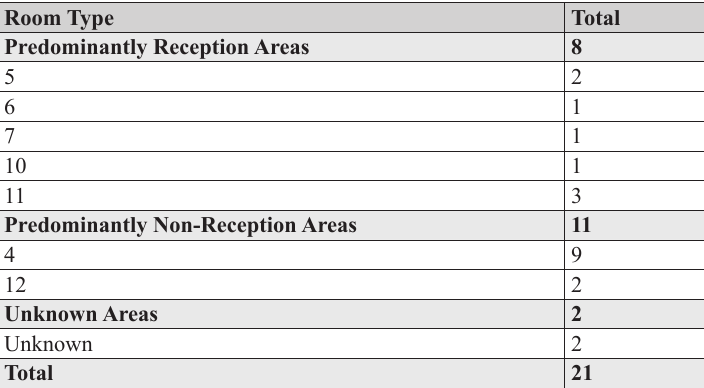
Table 3: The distribution of Venus Pescatrice representations in domestic contexts across room types Room Type Total Predominantly Reception